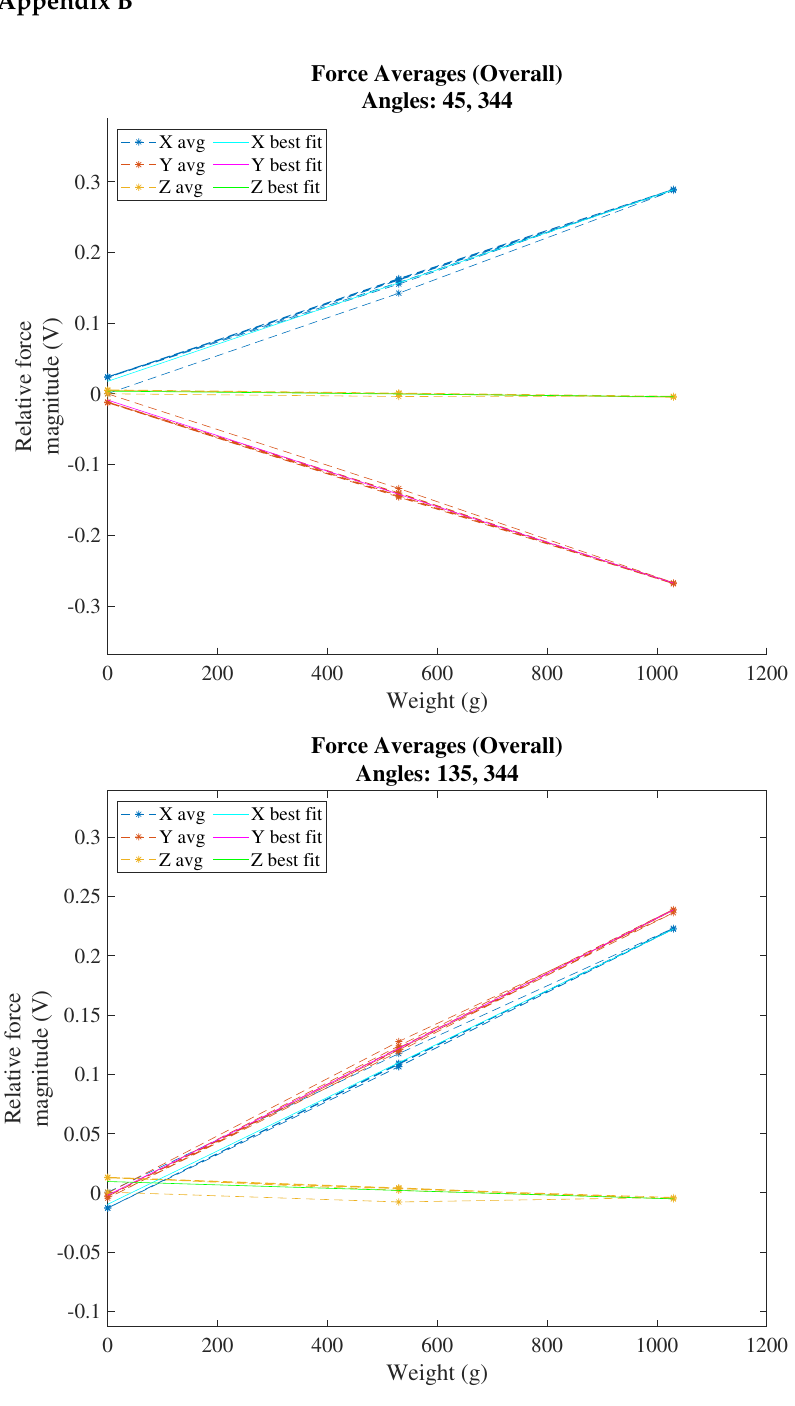
Figure A3. Voltage response to 3D calibration loading in different